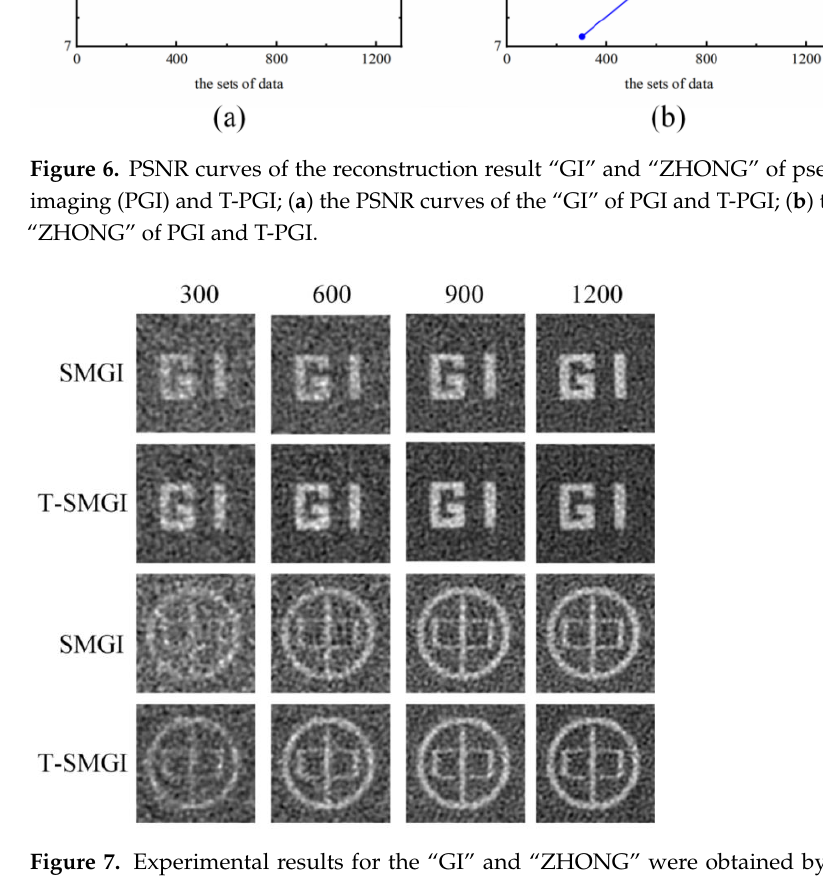
Figure 6. PSNR curves of the reconstruction result “GI” and “ZHONG” of pseudo-inverse ghost imaging (PGI) and T-PGI; ( a ) the PSNR curves of the “GI” of PGI and T-PGI; ( b ) the PSNR curves of “ZHONG” of PGI and T-PGI.